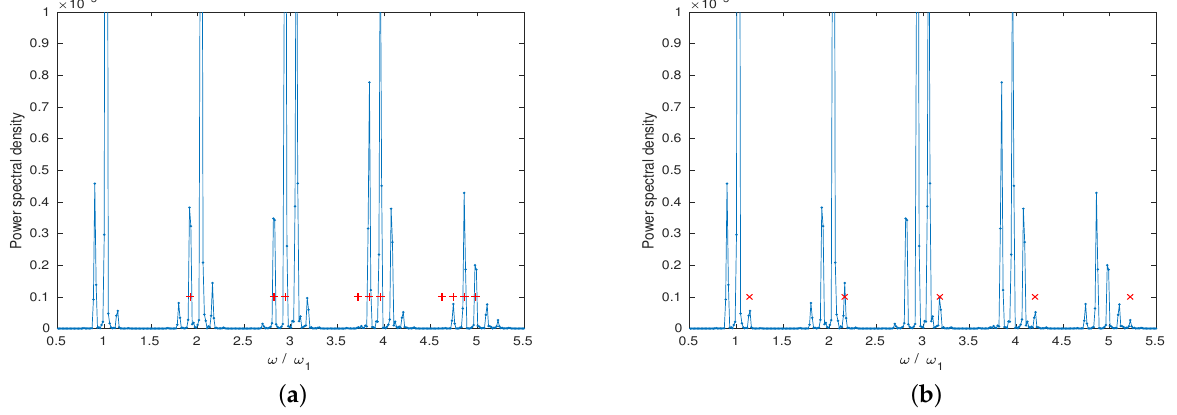
Figure 12. The frequency spectrum of coupled sway and roll cases under different excitation frequen- cies. excitation frequency : ω / ω 1 = 1.02, excitation amplitude : 0.001 m (sway); excitation frequency : ω / ω 1 = 0.90, excitation amplitude : 0.001 rad (roll). ( a ) sum frequency; ( b ) difference